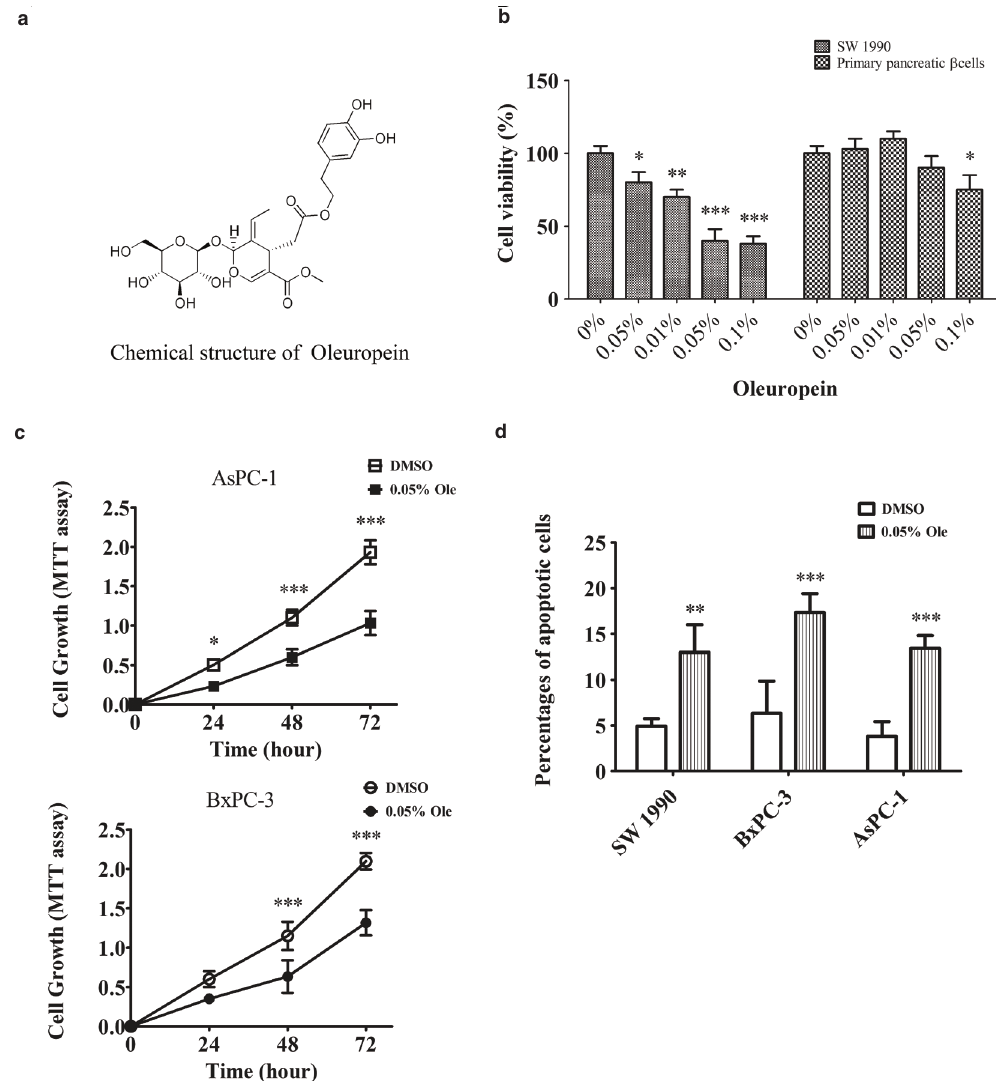
Fig. 1. Ole inhibits pancreatic cancer cells in vitro. (a) Schematic diagram of the chemical structure of Ole. (b) Cell viability study of SW 1990 or primary pancreatic β -cells under the treatment of Ole. Cells were treated with different doses of Ole for 48 h. The cell viability was measured by MTT assay. (c) Cell proliferation study of AsPC-1 and BxPC-3 lines under the treatment of Ole. Cells were incubated with either 0.05% Ole or DMSO. The cell growth was assessed by MTT assay every 24 h for 3 days. (d) Cell apoptosis study of pancreatic cancer cell lines under the treatment of Ole. Cells were treated with either 0.05% Ole or DMSO. Forty-eight hours later, the apoptotic cells were counted by Annexin V/PI staining. The data were presented as means ± SD of three independent experiments (* P < 0.05, ** P < 0.01, and *** P < 0.001 as compared with